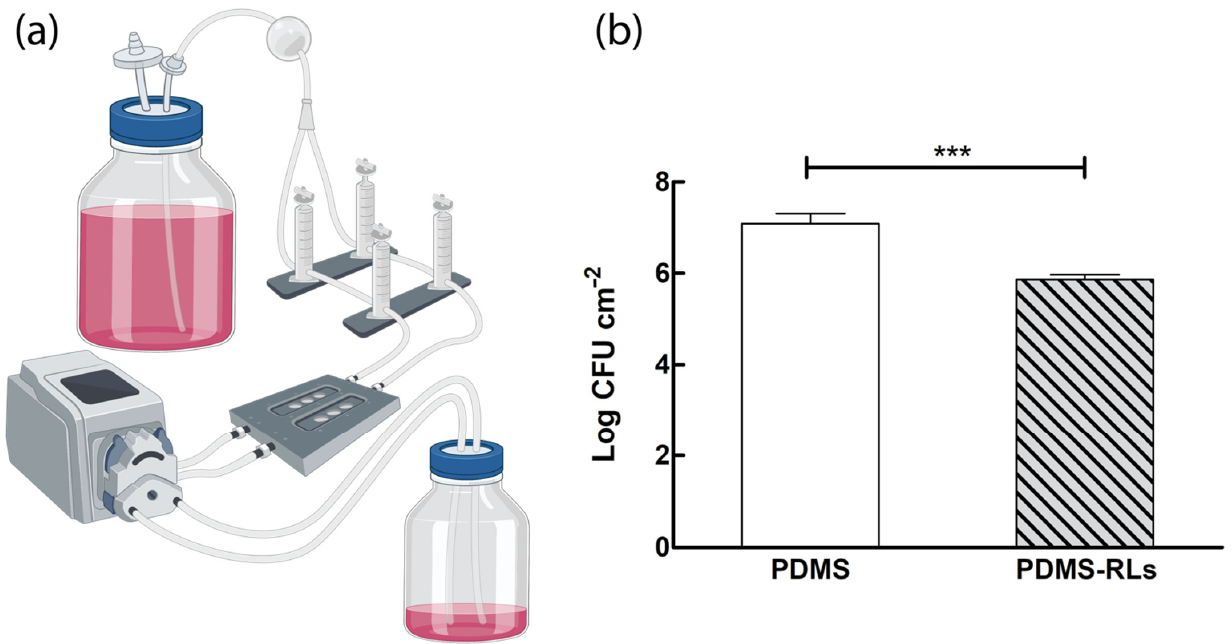
Figure 4. ( a ) Schematic representation of the flow dynamic assay to characterize surfaces antibiofilm activity; ( b ) S. aureus biofilm inhibition by RLs-functionalized surfaces under dynamic conditions assessed by colony forming unit counts (*** p < 0.01).